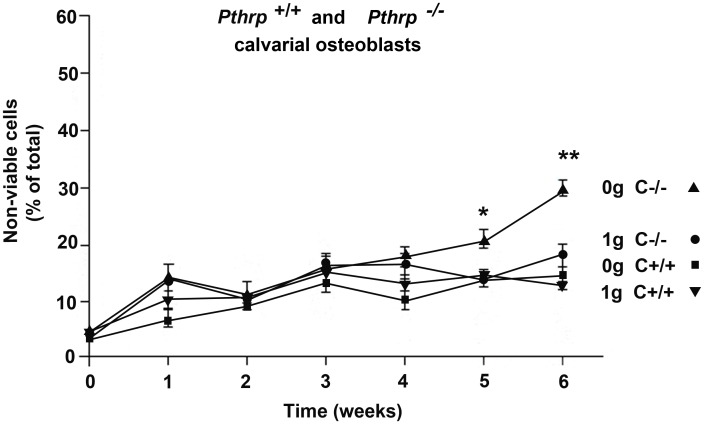
Long-term exposure to simulated microgravity has little negative effect on calvarial osteoblasts.Phtrp+/+ calvarial osteoblasts at 1g (▼) or 0g (■). Pthrp-/- calvarial osteoblasts at 1g (●) or 0g (▲). (triplicate 6-week experiments). No exogenous PTHrP1-36 treatment was applied in this experiment. Viability estimated by Trypan blue. * p < 0.05, ** p < 0.01.